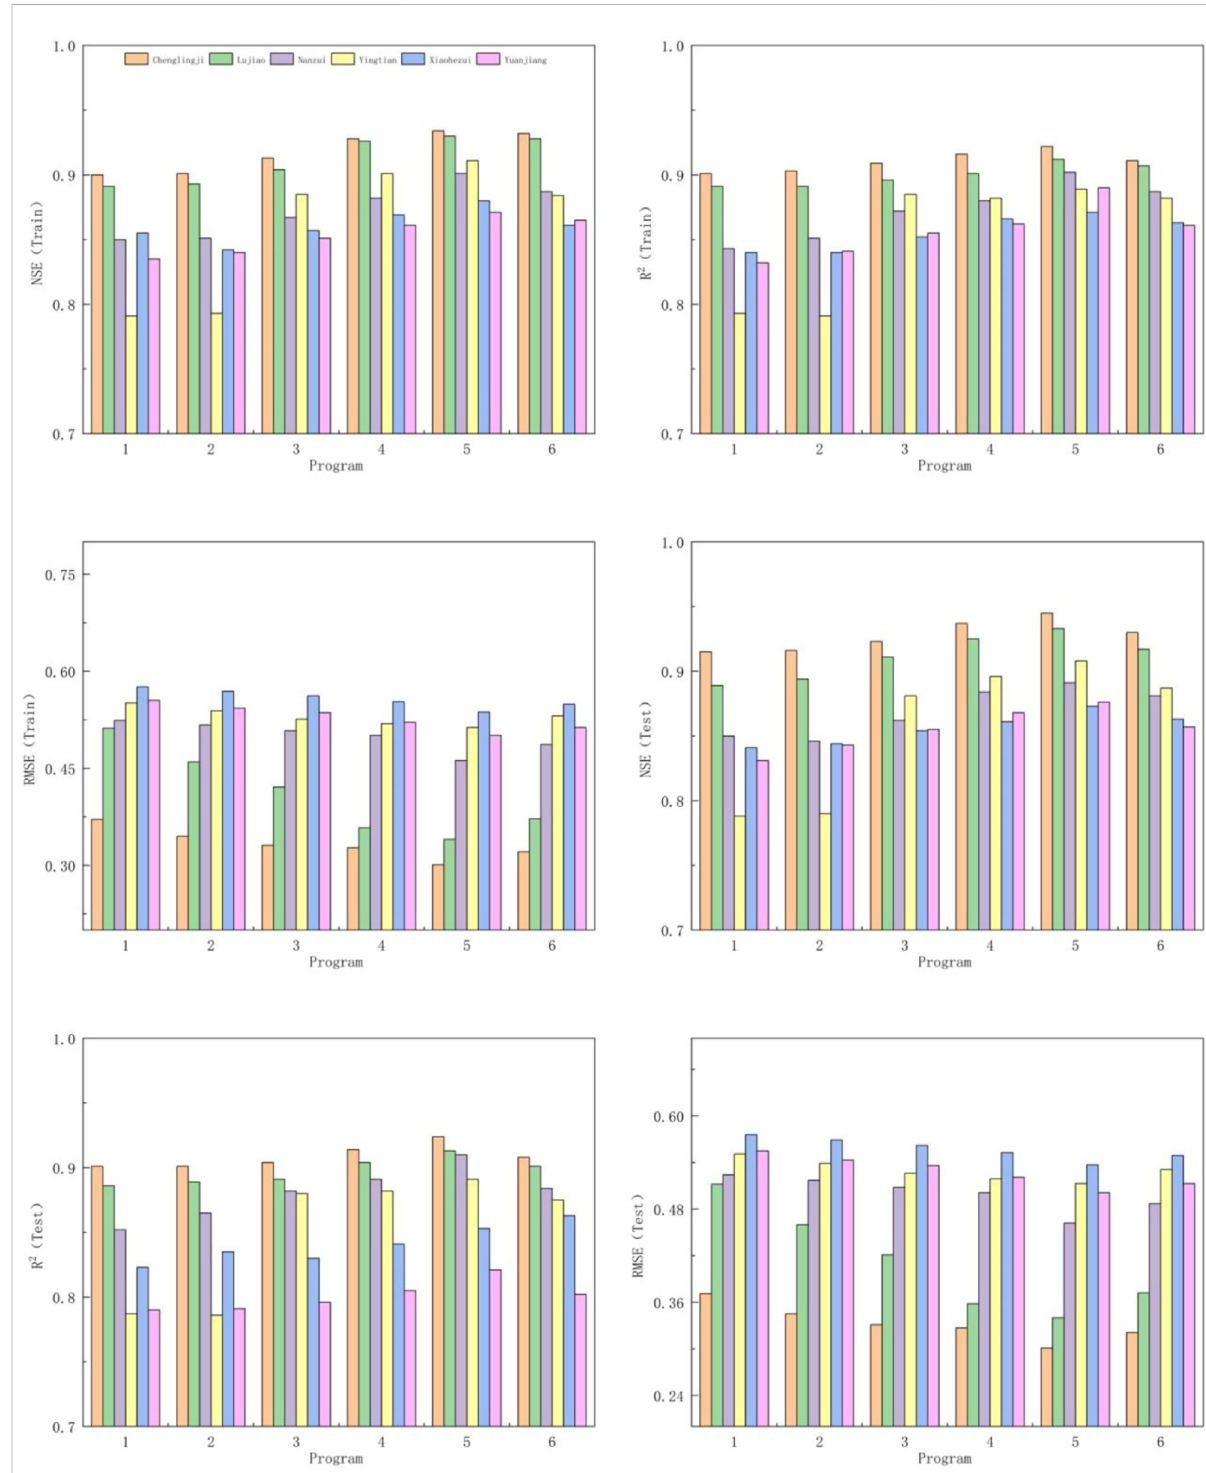
FIGURE 5 Simulation results of different input data processing schemes under the test